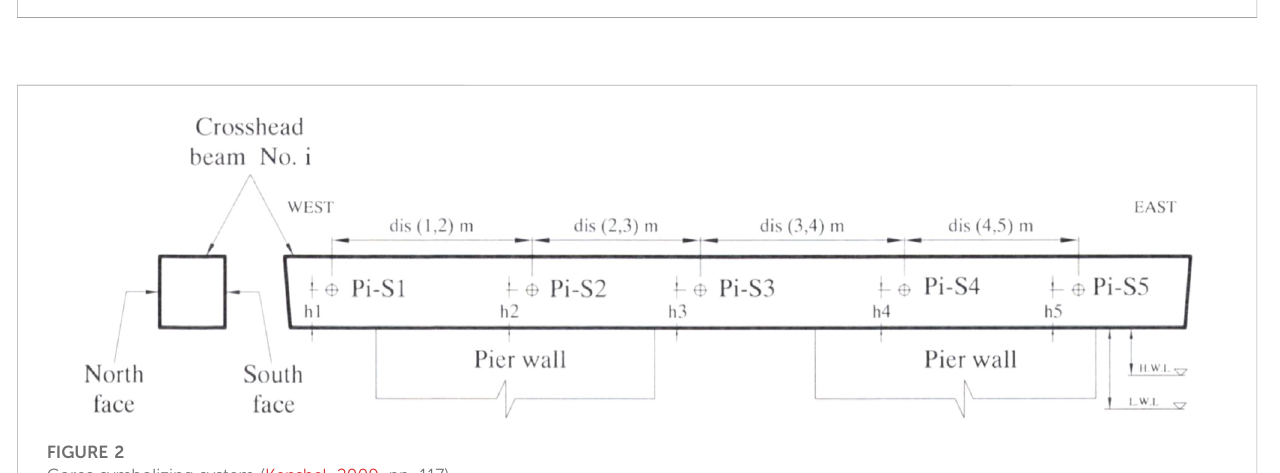
FIGURE 1 Photograph of the Ferrycarrig Bridge (piers #1 to #7 locations) (Kenshel, 2009, pp. 116).